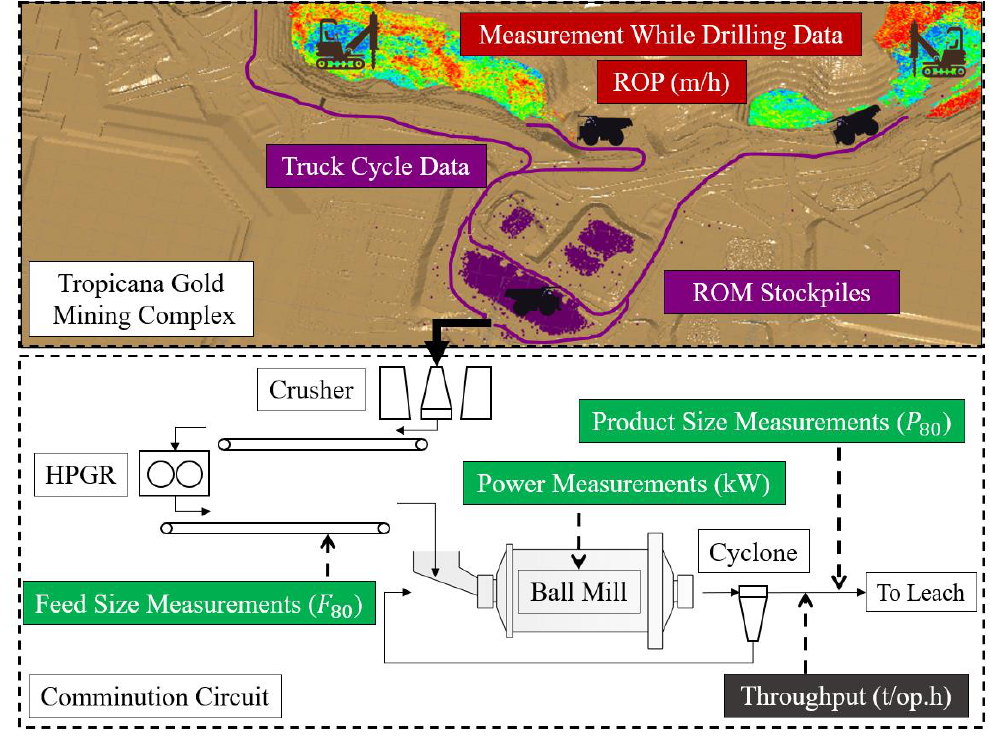
Figure 2. Material flow and utilized production data for ball mill throughput prediction in the Tropicana Gold mining complex.